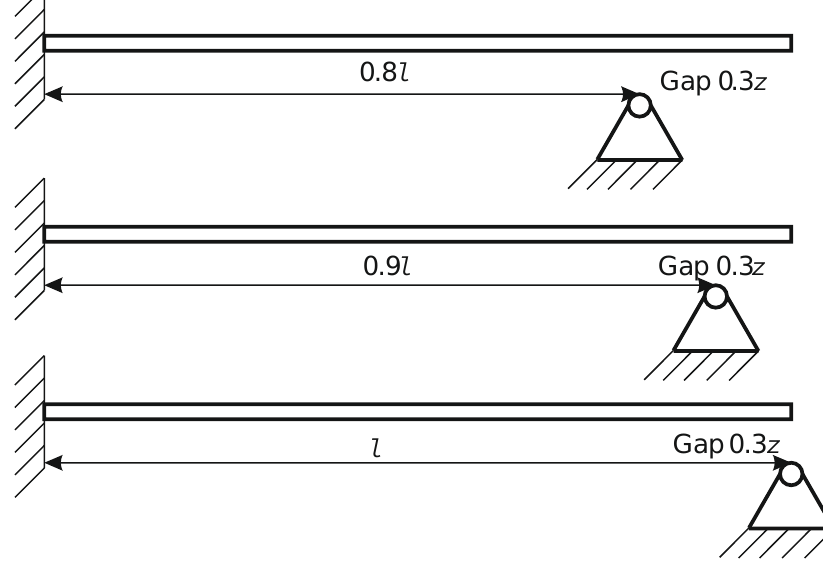
Figure 5. Stopper location at points approximately coinciding with the nodes of the 2nd ( x / l = 0.8), 3rd ( x / l = 0.9) modes of transverse vibrations and at the end of cantilever ( x / l = 1).